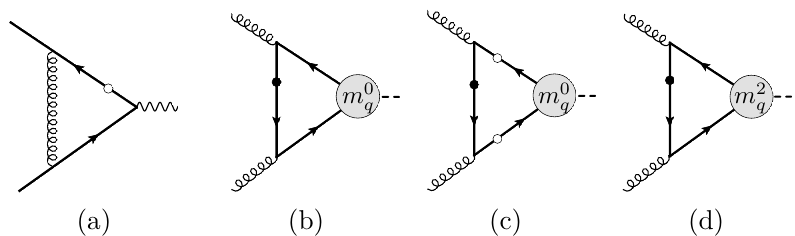
Figure 1 . (a) the leading-order one-loop Feynman diagram for the O ( m q ) logarithmic contribution to the quark Pauli form factor. The Feynman diagrams representing (b) O ( m q ) and (c), (d) O ( m 3 double-logarithmic contributions to the ggH amplitude. The black (empty) circle represents the mass (loop momentum) insertion. The gray blobs correspond to the double-logarithmic off-shell scalar form factor at O ( m 0 ) and O ( m 2 ) . Symmetric diagrams and the diagrams with the opposite q q direction of the closed quark line are not